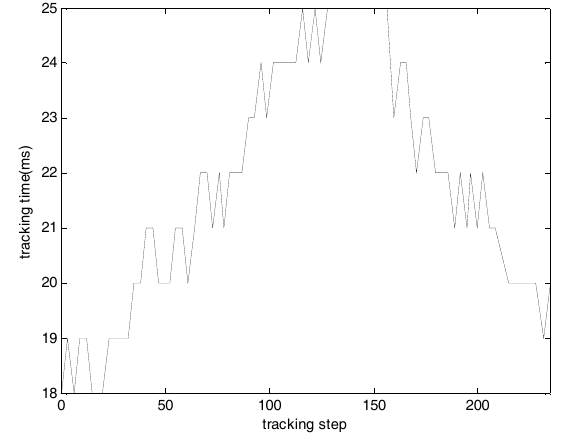
Figure 17. Tracking time for a real star sensor.